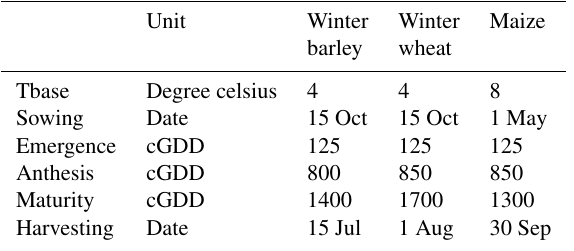
Table 1. Crop characteristics of arable crops in Belgium (Gobin, 2010, 2012).